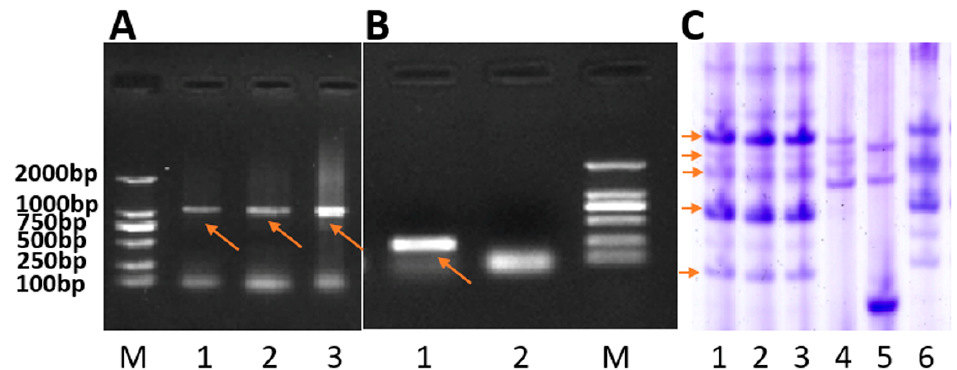
Figure 2. Chromosome identification of RT843-5 by PCR and A-PAGE. ( A ): PCR results obtained with the primer pair ω -Sec-P. Lanes 1 to 3: different RT843-5 plants; Lane M: DNA marker DL2000. The arrows show the specific bands amplified by ω -Sec-P. ( B ): PCR results obtained with the primer pair Gil-B1. Lane 1: MY11; lane 2: RT843-5; and lane M: DNA marker DL2000. The arrows show the specific bands amplified by Gil-B1. ( C ): A-PAGE separations of ω -secalin from RT843-5. Lanes 1 to 3: different seeds from RT843-5; lane 4: Chinese Spring; lane 5: MY11; lane 6: CN11. The arrows show the ω -secalin proteins encoded by the Sec-1 gene.